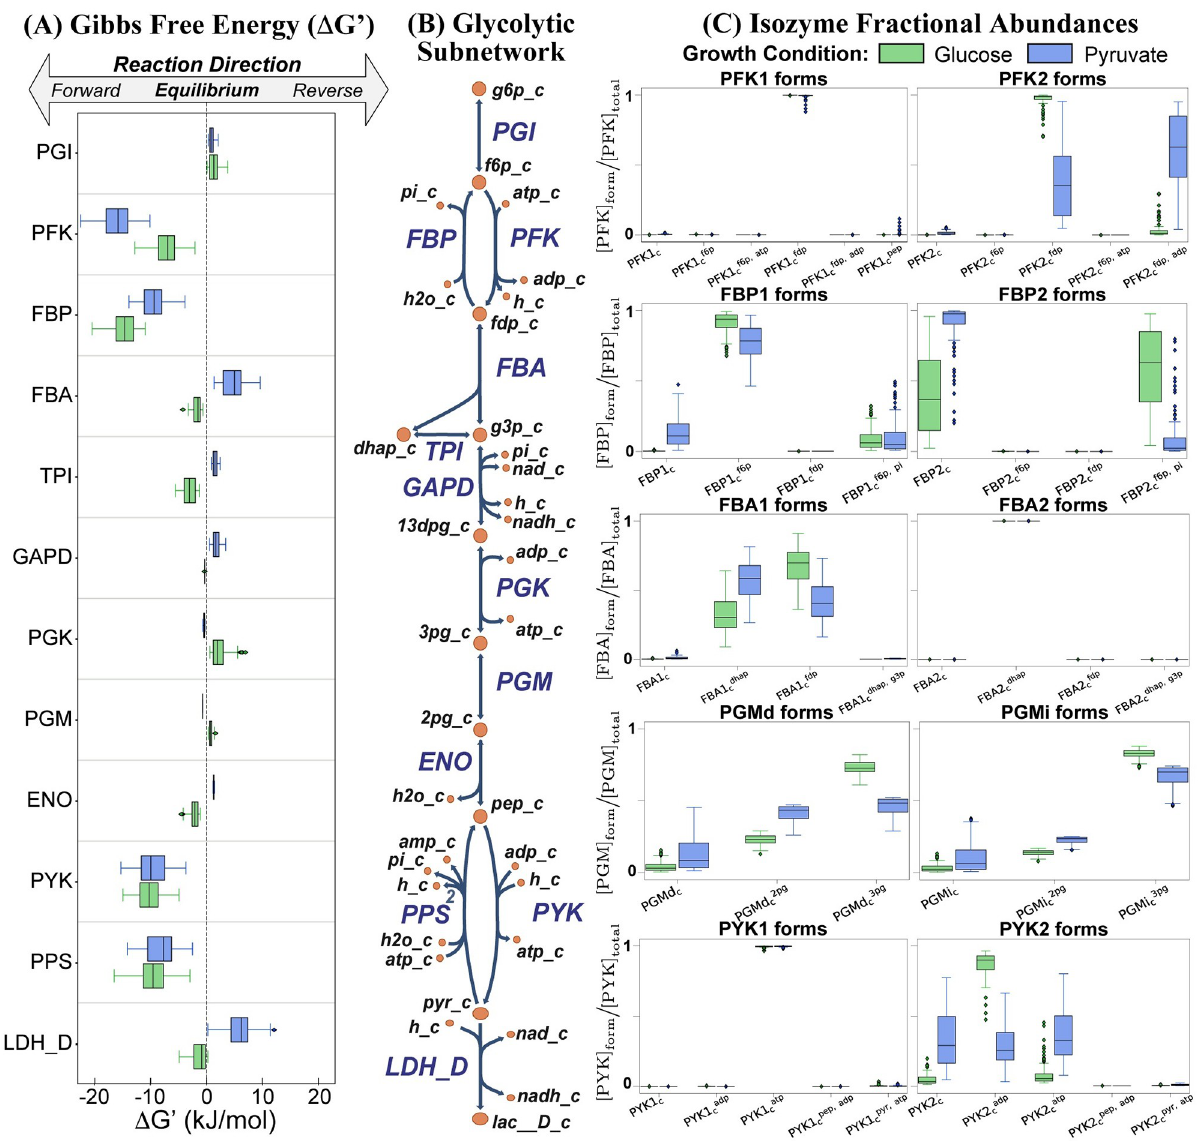
Fig 4. Comparison of free energy and isozyme fractional abundances for carbon sources. (A) The Gibbs free energy represents the thermodynamic driving force, shifting the metabolic state depending on the carbon source. (B) The glycolytic subnetwork extracted from E. coli iML1515 consists of 12 reactions represented by the 17 enzyme modules. (C) The fractional abundance for each enzyme form can be computed and compared for the different isozyme pairs, providing insight into how the catalytic activity is distributed across the isozymes in glucose and pyruvate growth conditions. The fractional abundances for all enzymes can be found in the supplement (S2